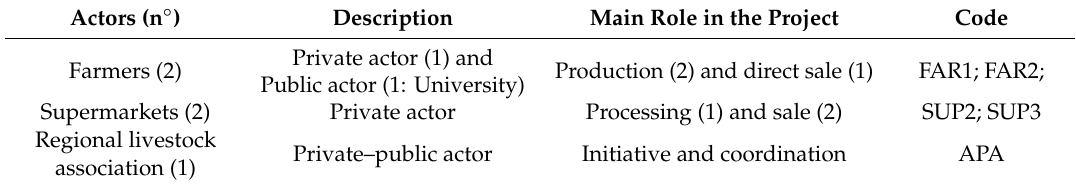
Table 1. Actors description. FARn indicates the surveyed farms; SUPn, the supermarkets; and APA, the local livestock